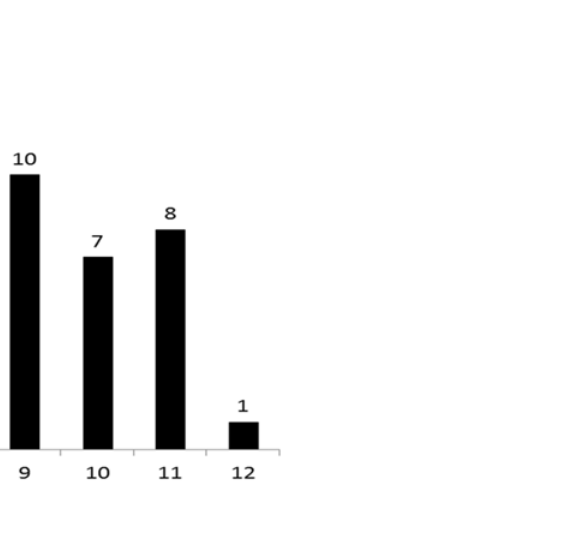
Figure 1. Distribution of non-O1 Vibrio cholerae infections by